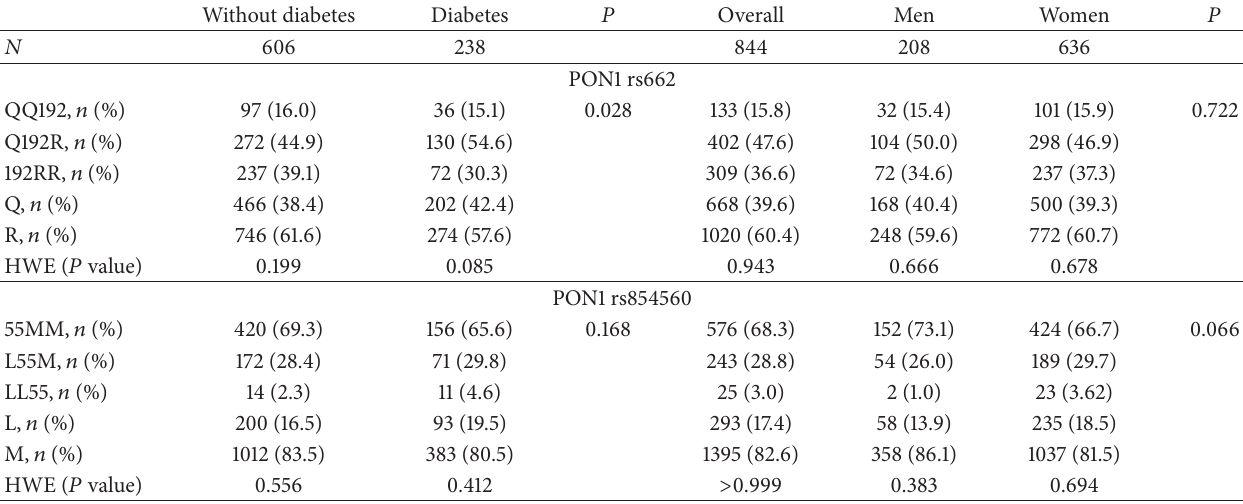
Table 1: Genotype distributions, minor allele frequencies, and unadjusted 𝑃 values for comparing genotype distributions according to diabetes status, and additive allelic effects between diabetes groups. Without diabetes